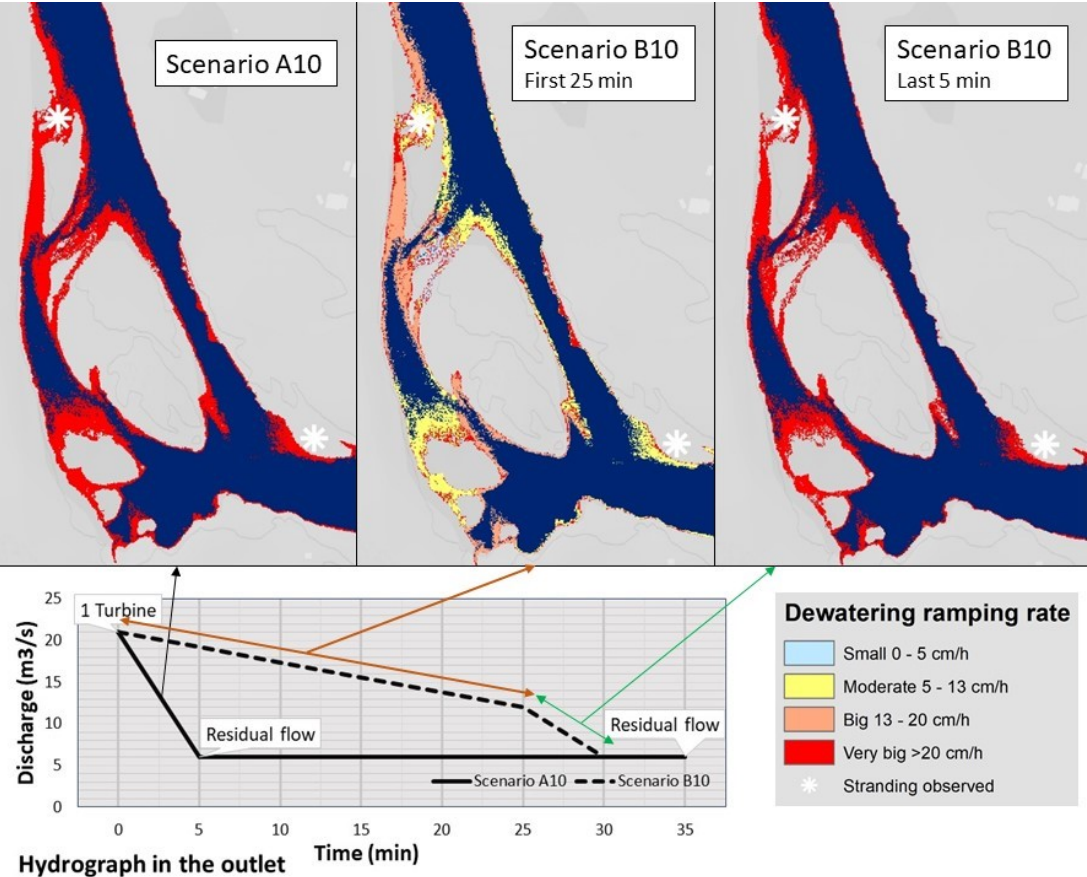
Figure 9. Dewatering rate (cm/h) in scenarios A10 and B10 in Ellingøyne, blue shows the wetted areas at the end of the ramping, the rest of the colors display the impact in the areas that are dried out during the ramping, the white stars show the areas where fish stranding has been observed.